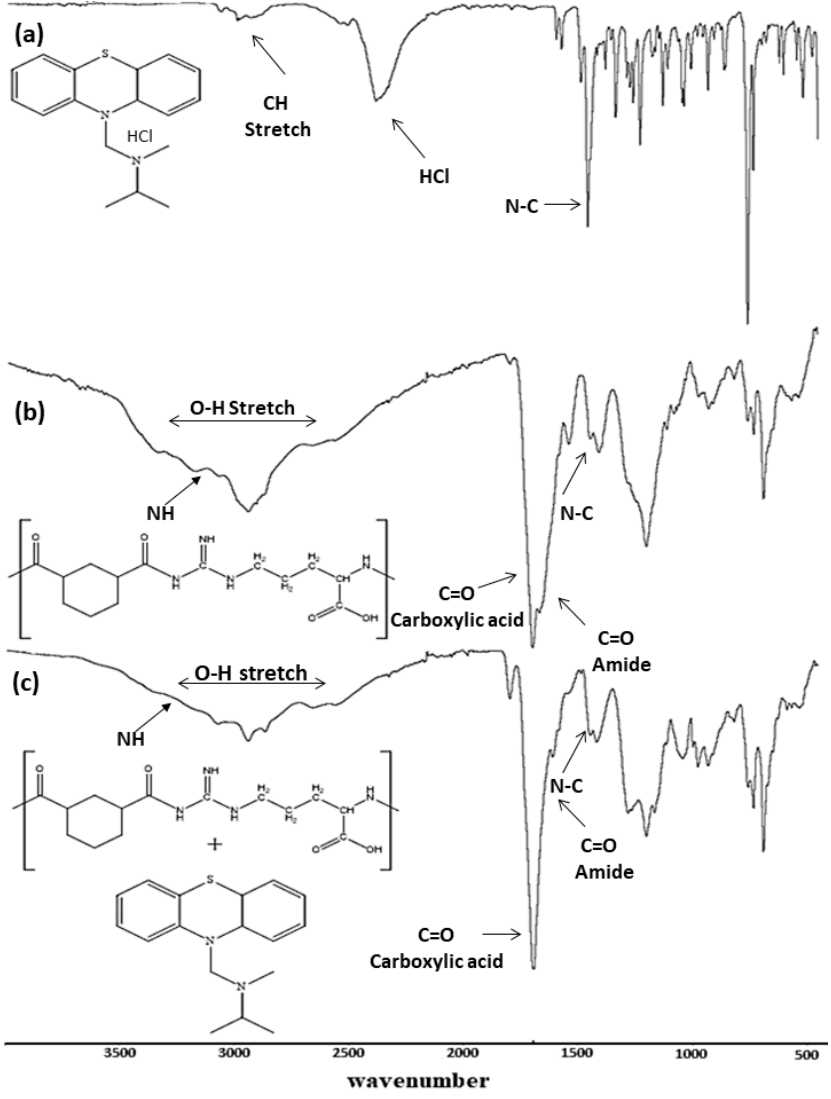
Figure 2. FTIR spectra of ( a ) PMZ drug, ( b )Arg-PA, and ( c ) PMZ/Arg-PA NCs . Table 2. FTIR spectral properties of PMZ, Arg-PA, PMZ/Arg-PA.